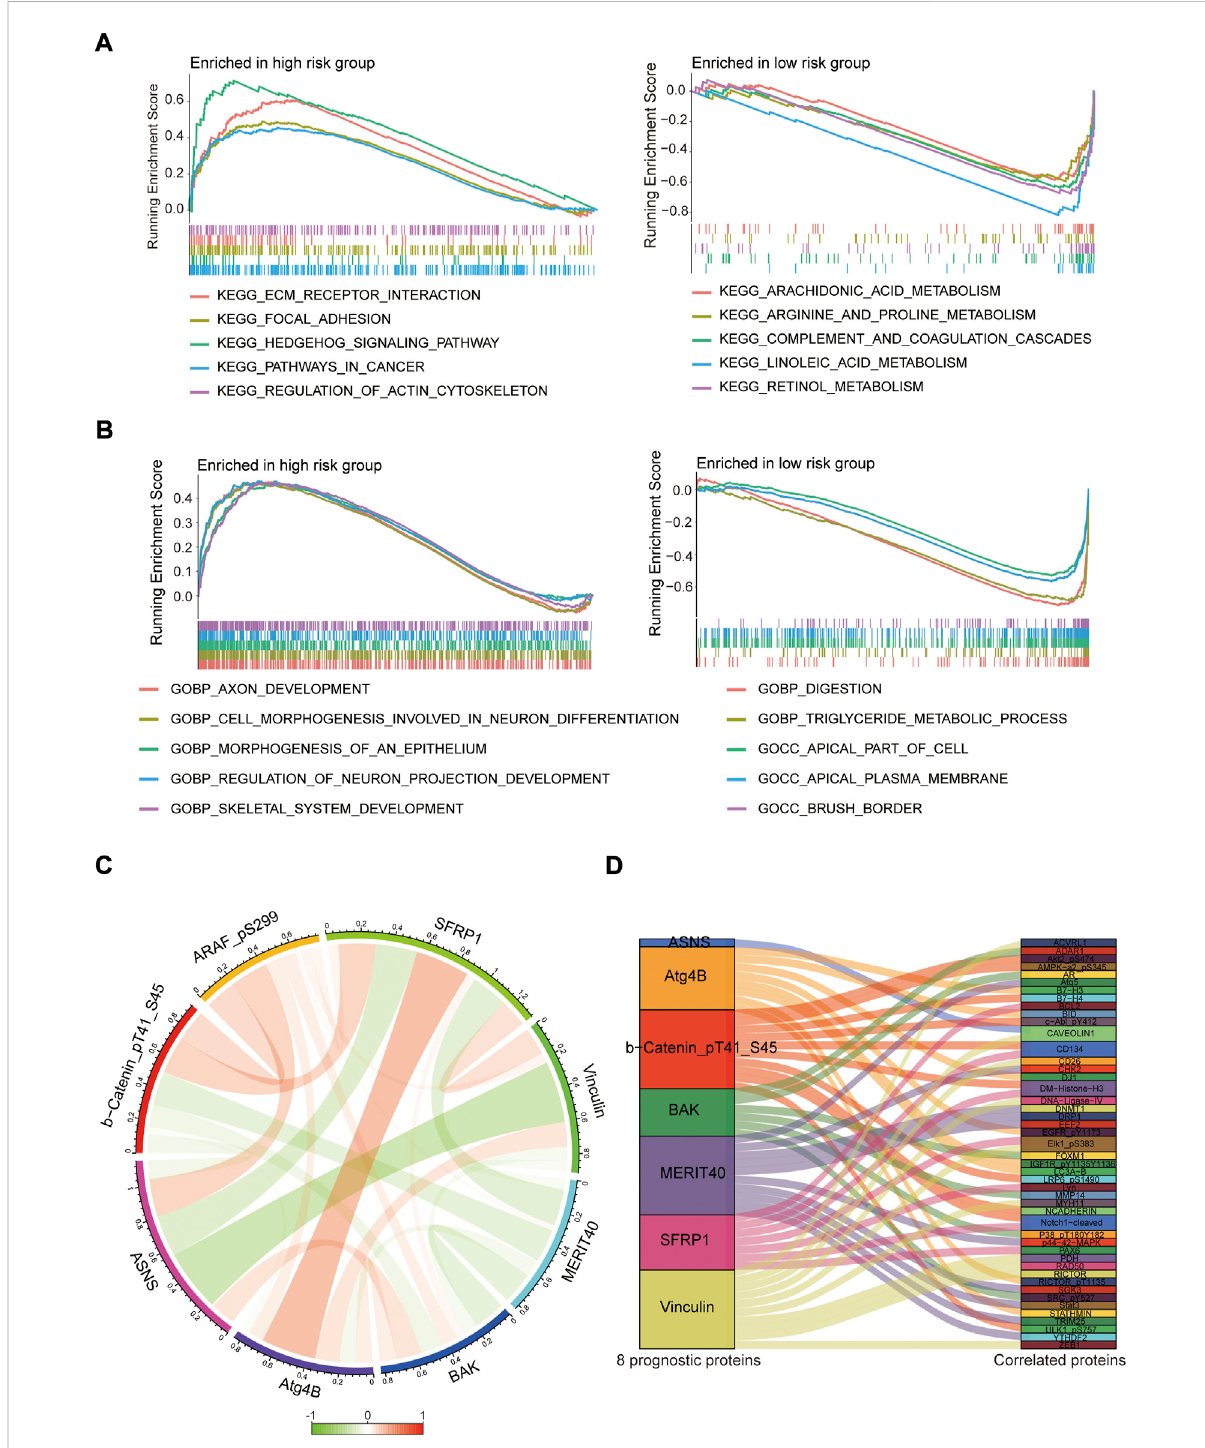
FIGURE 9 Pathway enrichment analysis and protein interaction network. (A,B) The top 5 KEGG and GO pathways enriched in the high- and low-risk groups. (C) The interaction relationships among 8 prognostic proteins in circos plot. (D) Analysis of co-expressed proteins in EC in sankey